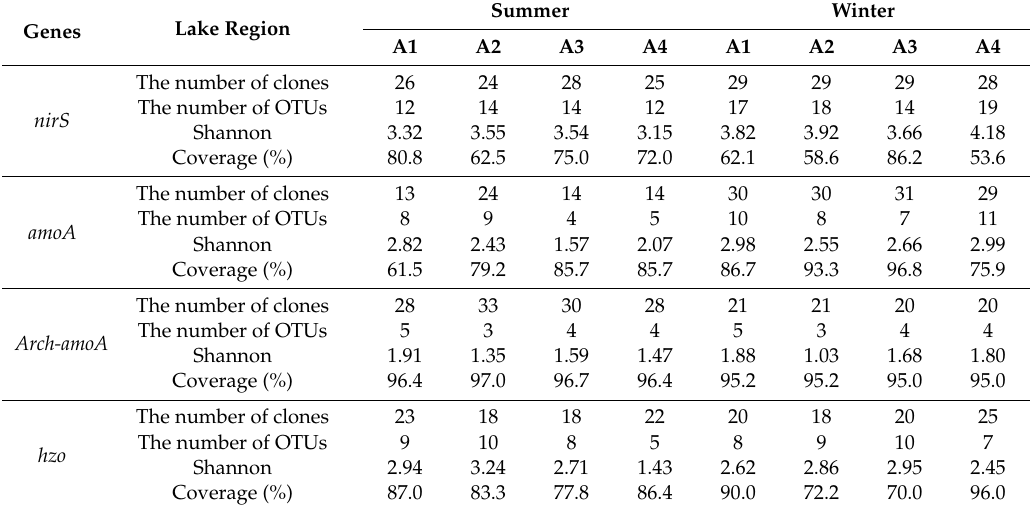
Table 1. Diversity properties of the nitrogen-transforming genes clone libraries from di ff erent lake